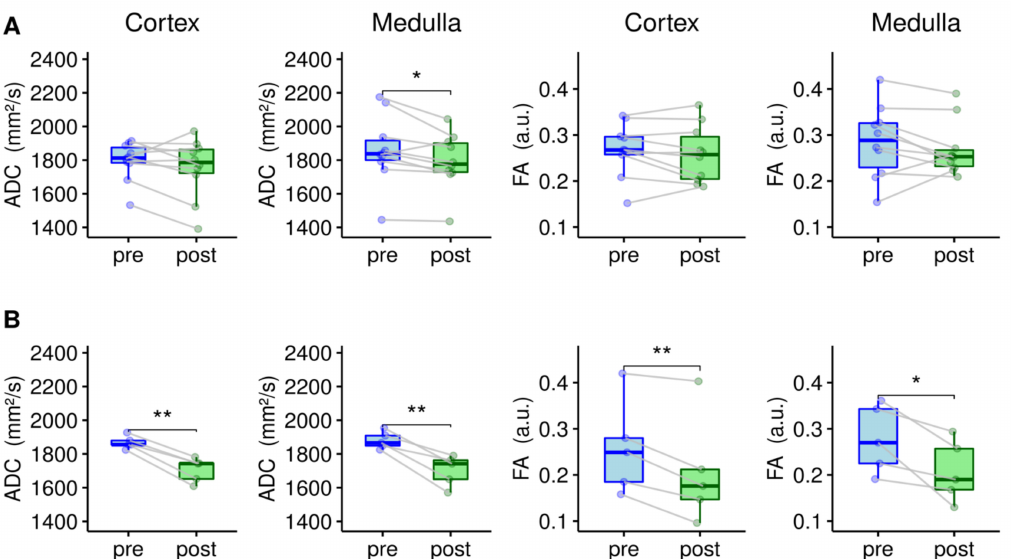
Figure 1. Boxplots of cortical and medullar apparent diffusion coefficient (ADC) and fractional anisotropy (FA) values pre- and post-XCM. Patients were divided into two groups (non-Contrast-Induced Nephropathy (non-CIN), n = 10 ( A ); CIN, n = 5 ( B )). Points indicate the values for each individual and boxplots represent the mean over all patients of the group. Lines connecting the individual points represent the pre/post ADC and FA difference of the single patients. For the non-CIN group, only pre- and post-medullar ADC values were significantly different (* p < 0.05). All other diffusion parameters of the non-CIN patients did not differ significantly pre- and post-XCM administration. A significant drop of all diffusion parameters was identified for the CIN group (* p < 0.05). ** p < 0.01.